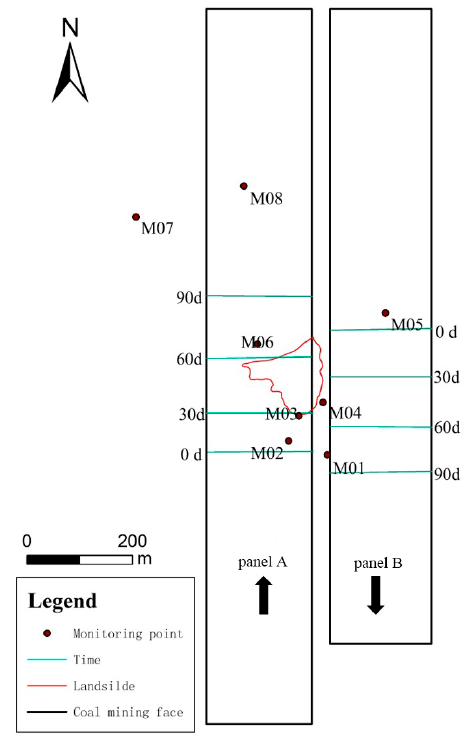
Figure 3. Map of the advancing work face of the mining activity in panels A and B.